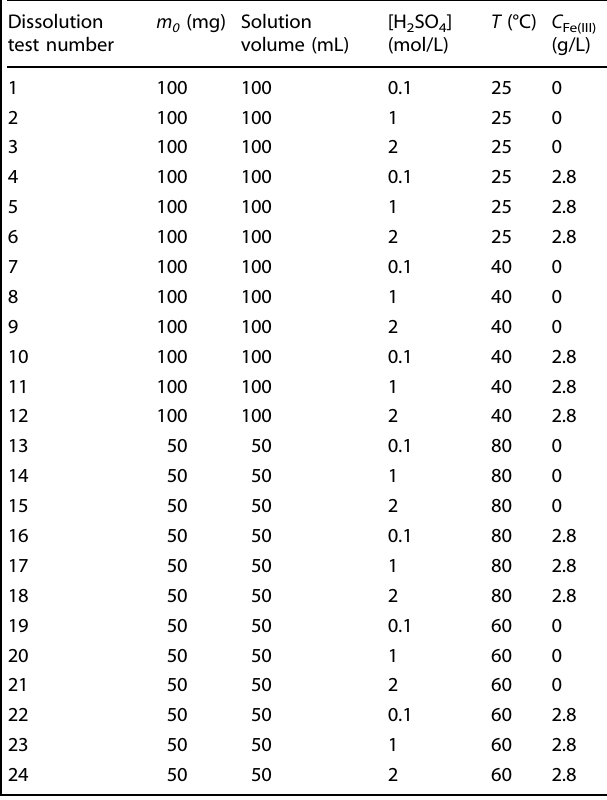
Table 3. Experimental conditions considered for the dissolution tests performed on synthetic